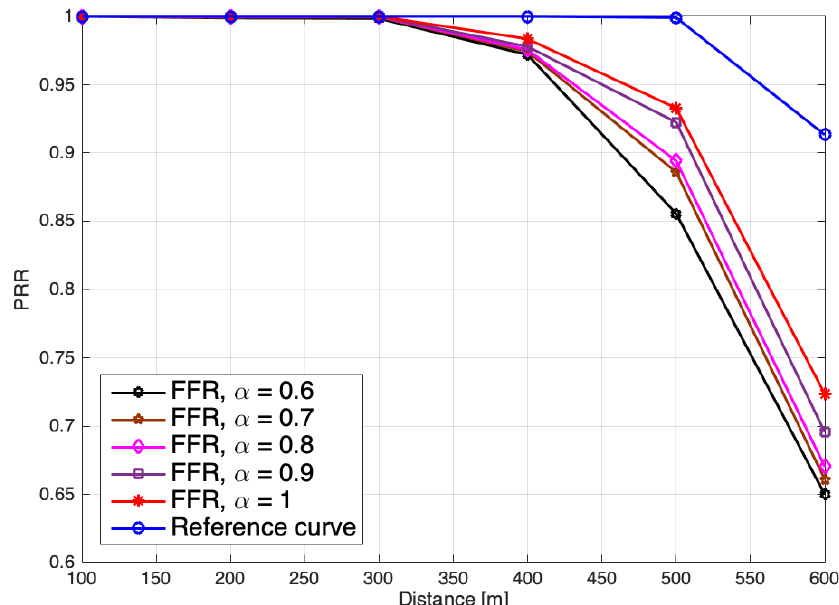
Figure 5. The Packet Reception Ratio (PRR) of vehicles’ CAM messages broadcast for different vehicle density factors with bandwidth partitioning using the Full Frequency Reuse (FFR) technique.